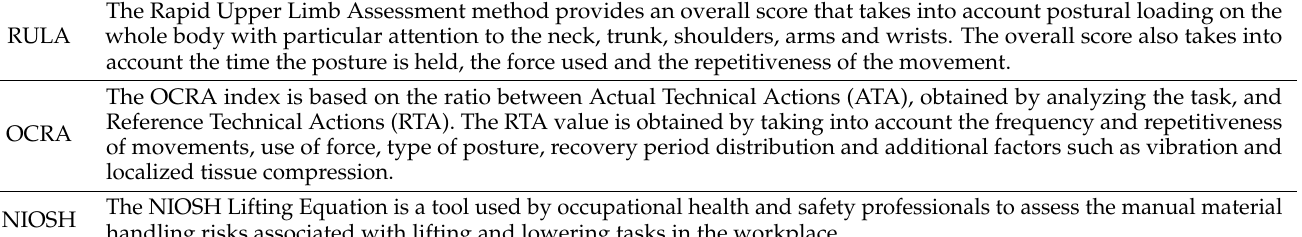
Table 2. Principal ergonomic indices used to assess MSDs